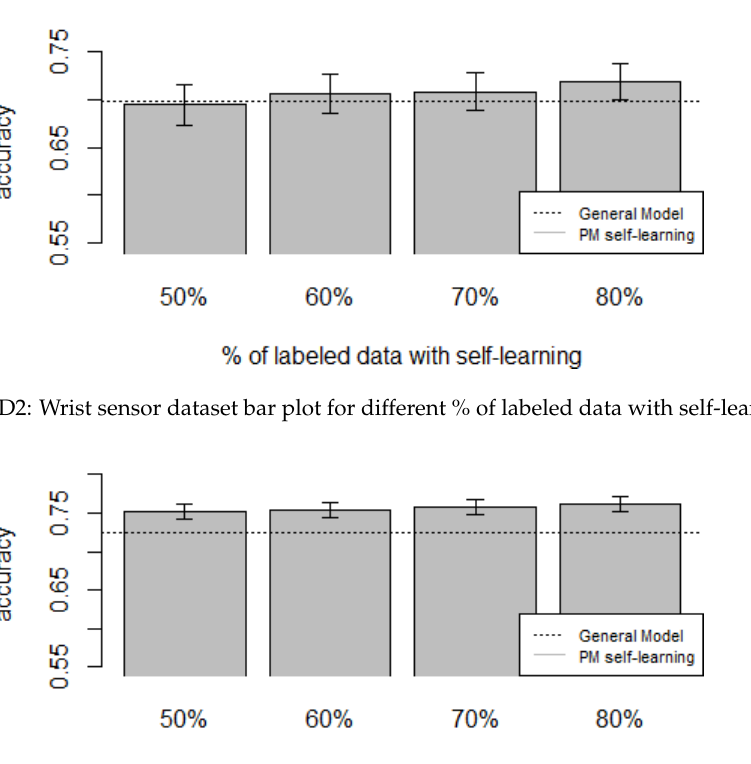
Figure 10. D1: Chest sensor dataset bar plot for different % of labeled data with self-learning.